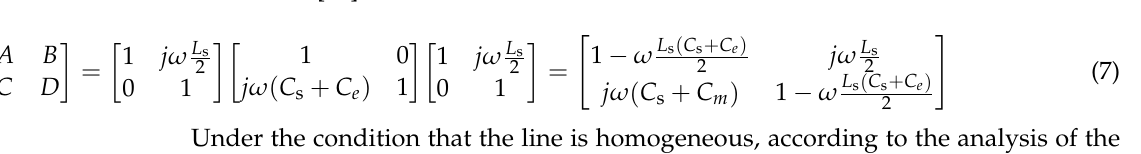
Figure 3. The serpentine structure: ( a ) topology and ( b ) equivalent circuit. Since there is no major line width variation, it is equivalent to series inductance L s and capacitance to ground C s , as a T network. The corner can generate extra electric cou- pling, which can be regarded as an extra capacitor C e . The characteristic impedance of the line is Z s and the electrical length is θ s . According to the cascading principle, its ABCD matrix can be calculated as [32]